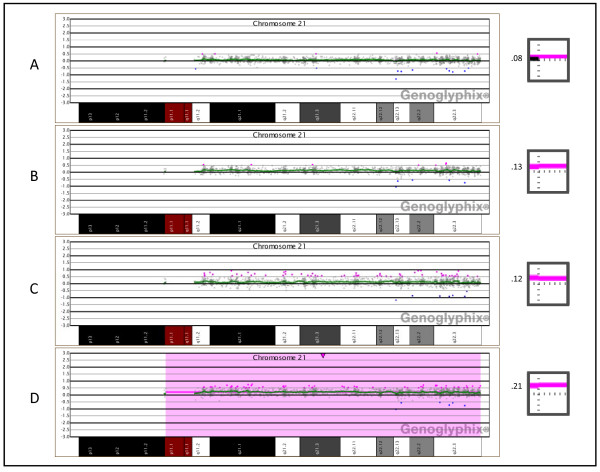
Oligonucleotide microarray analysis of artificially derived mosaic trisomy 21 samples. (A) 10% trisomy 21 showing a very subtle copy-number gain for all clones on chromosome 21. The profile was generated using DNA extracted from a mixture of blood which contained 10% WBCs from a trisomy 21 subject and 90% WBCs from a normal male individual. (B) 15% trisomy 21, generated as in (A), showing a very subtle copy-number gain for all clones on chromosome 21. (C) 20% trisomy 21, generated as in (A) showing a subtle copy-number gain for all clones on chromosome 21. (D) 30% trisomy 21, generated as in (A), showing a clear copy-number gain for all clones on chromosome 21. The inset images to the right of each array plot show the average log2 ratio of all probes mapping to chromosome 21, with the horizontal dotted line representing a log2 ratio of zero and the vertical dotted line representing the centromere. A pink bar plotted above the horizontal line represents a copy-number gain of all probes on chromosome 21. To the left of each inset image is the average log2 ratio at the specified proportion of trisomic cells.